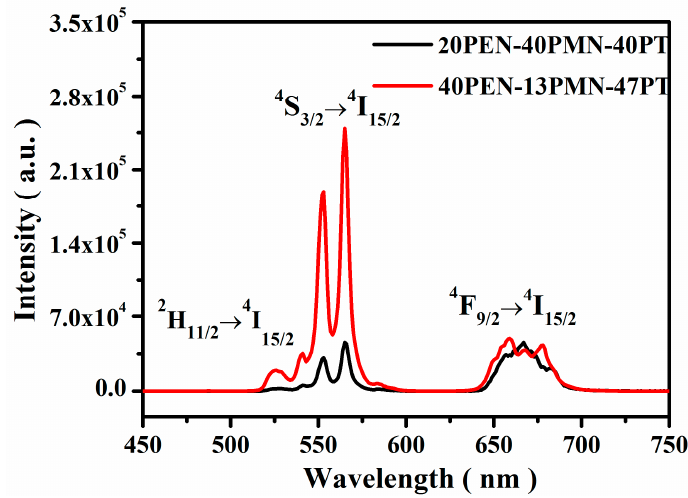
Figure 7. The UC emission spectra of the PEN-PMN-PT crystals under 980 nm excitation.